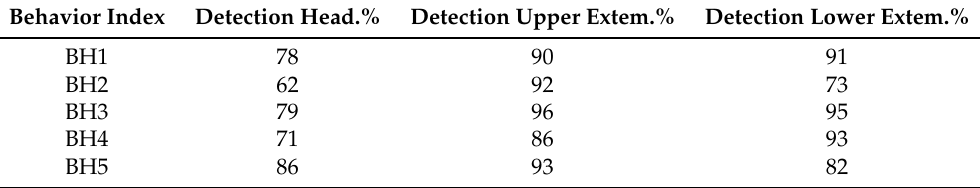
Table 2. Tabulation of the behavioral index used in the classification of neonate’s movement using infrared (IR)-kinect detector.